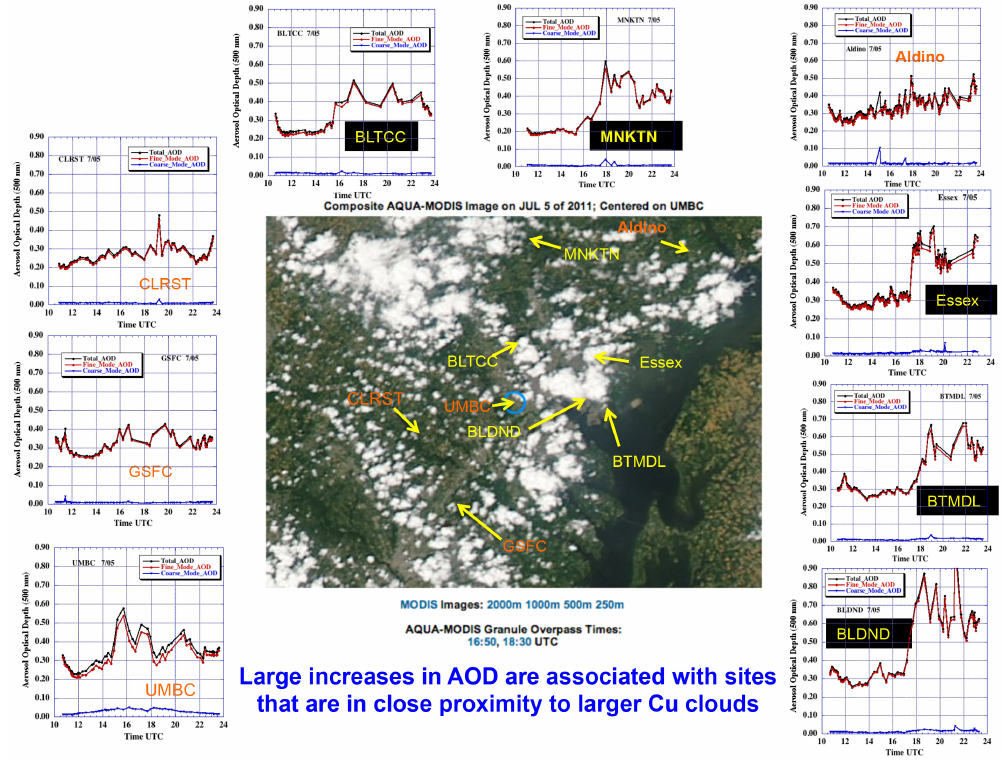
Figure 5. The Aqua MODIS satellite image centered on the UMBC site for 5 July 2011, showing the locations of selected AERONET sites. The time series of the fine and coarse mode AOD for each of these AERONET sites as determined by the spectral deconvolution algorithm (SDA) are also